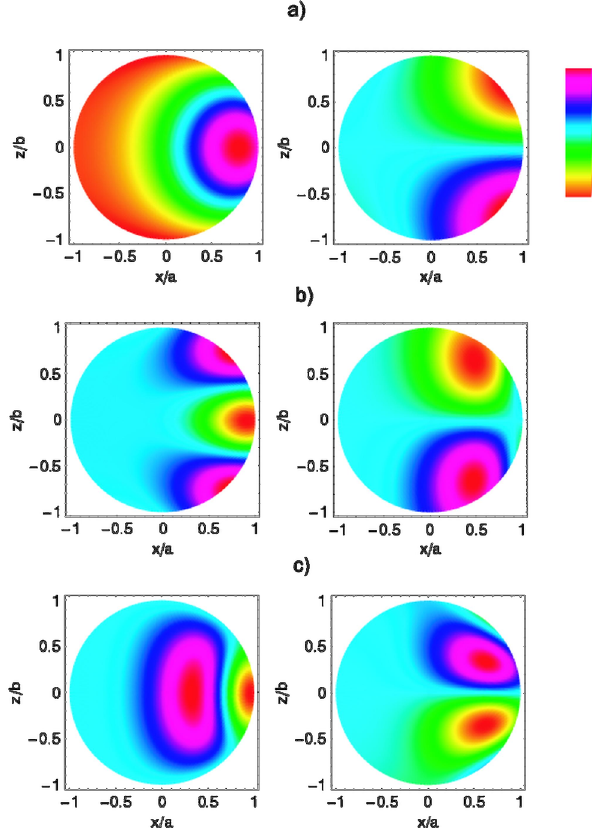
FIG. 4. (Color) Field profiles for a round cross section of the waveguide for the three lowest antisymmetric modes: (a) kR (cid:5) 1 = 2 a 3 = 2 (cid:1) 2 : 12 ; (b) kR (cid:5) 1 = 2 a 3 = 2 (cid:1) 3 : 95 ; (c) kR (cid:5) 1 = 2 a 3 = 2 (cid:1) 4 : 82 . The left plot in each pair of graphs shows distribution in the mode, and the right one shows the distribution of the E r . The color coding palette is shown in the upper right of E z corner of the